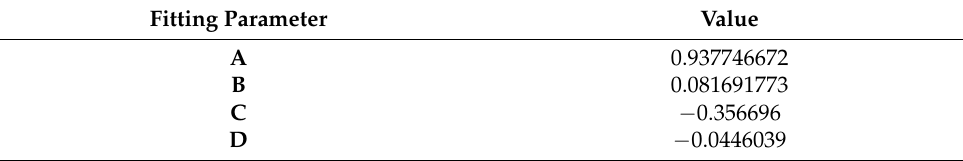
Figure 4. Fitting angle–amplitude (T PS ) data of CTP 38 in the oil reservoir.